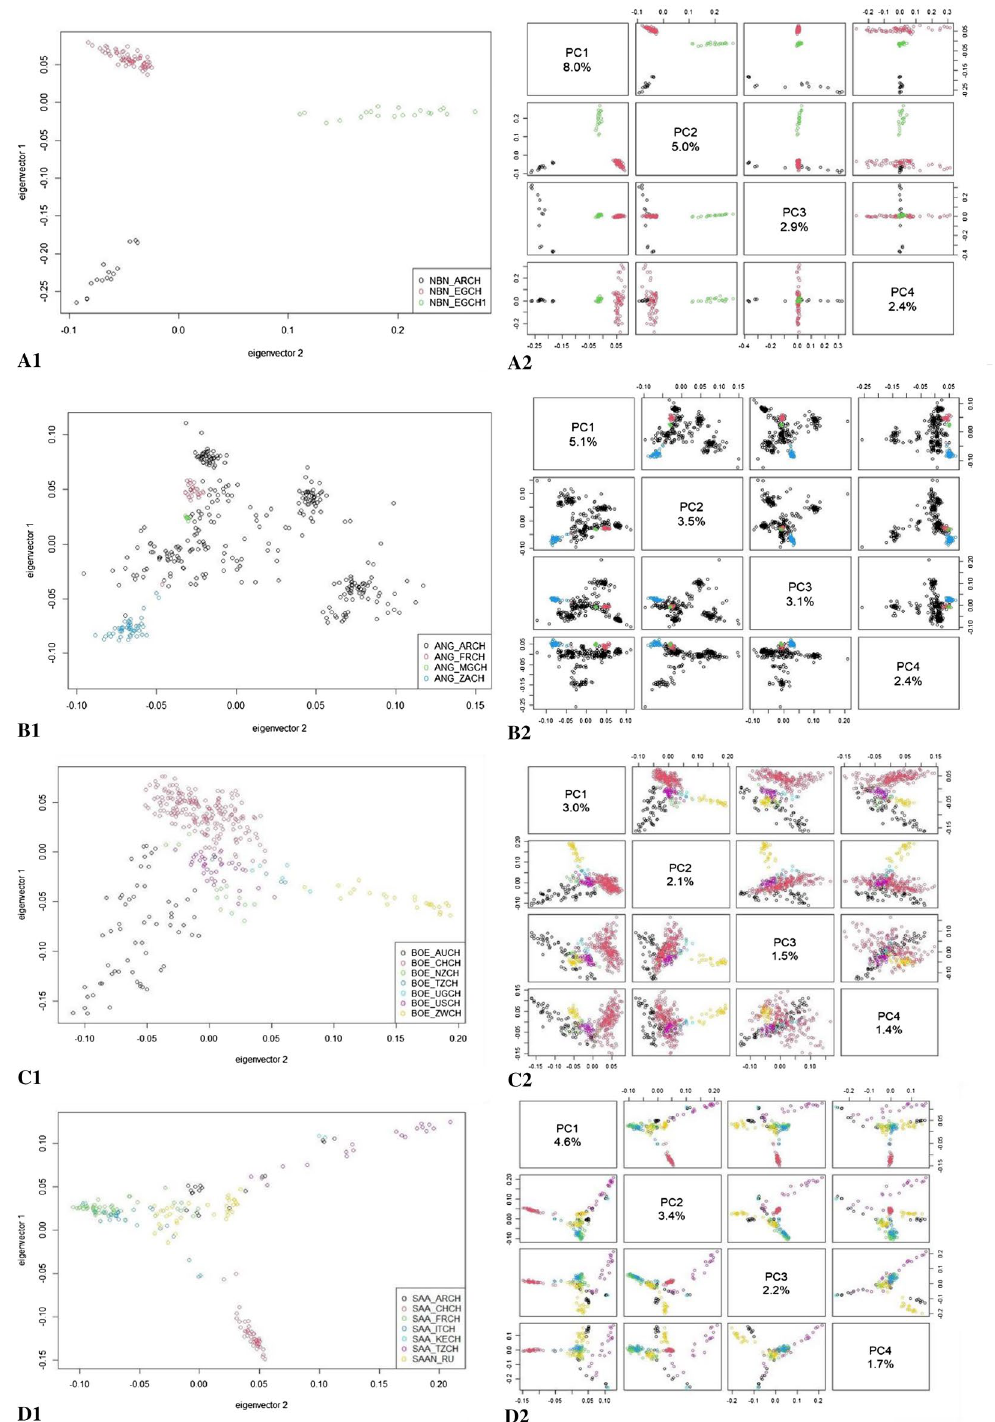
Figure 1. Distribution of samples in relation to their scores on the first and second principal components obtained after principal component analysis for the four breeds. Each point represents a single individual and for each breed a different colour was assigned. The legend that explains the correspondence between breeds and colour is in the lower right corner. ( A ) In the Nubian breed, after separation due to a subpopulation from Egypt, the percentage of variance explained up to 13% (eigenvector 1, X-axis, 8% and eigenvector 2, Y-axis, 5%). ( B ) In the Angora breed, the two components explained 8.6% of total variation (eigenvector 1, X-axis, 5.1% of variation and eigenvector 2, Y-axis, 3.5%). ( C ) In the Boer breed, the total percentage of variance is 5.1% (eigenvector 1, X-axis, 3% and eigenvector 2, Y-axis, 2.1%). ( D ) In the Saanen breed, the variance was a total of 8% (eigenvector 1, X-axis, 4.6% and eigenvector 2, Y-axis,